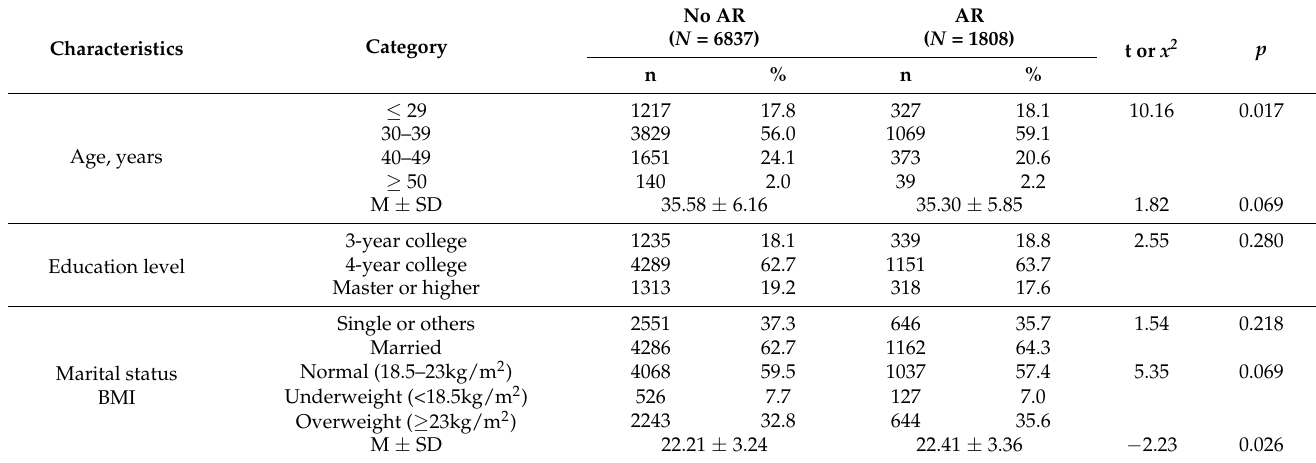
Table 1. Baseline characteristics according to allergic rhinitis ( N =